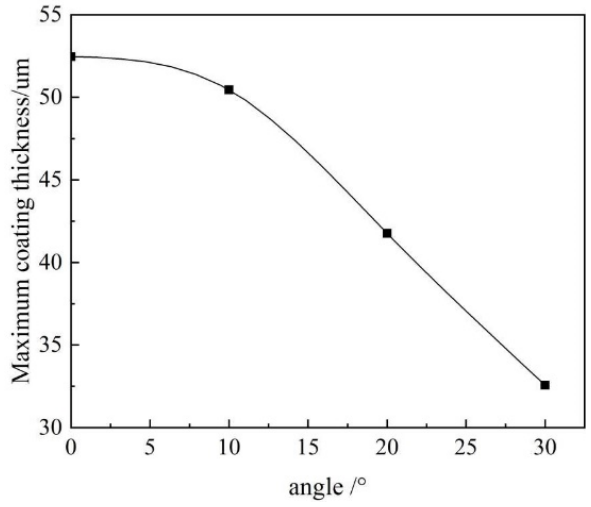
Figure 8. Variation law of maximum coating film thickness with spraying angle.